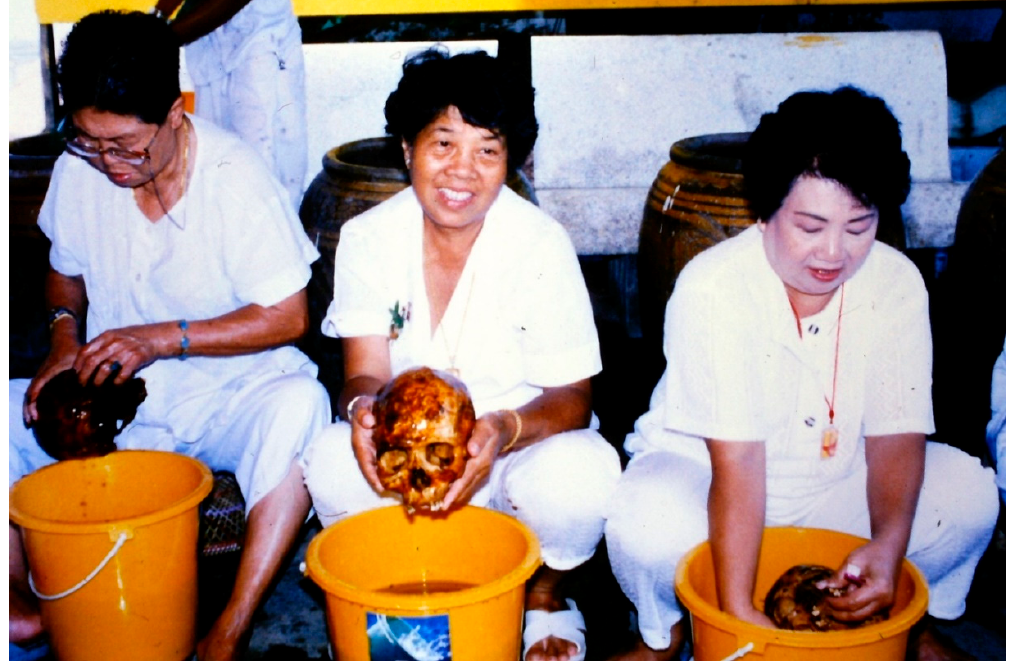
Figure 3. Déji ā o bones’ gatherers washing skulls during a xi ū g ū gú , Roeit, Thailand, 1994 (© B. Formoso). Figure 3. D é ji¯ao bones’ gatherers washing skulls during a xi¯u g¯ug ú , Roeit, Thailand, 1994 ( © B.